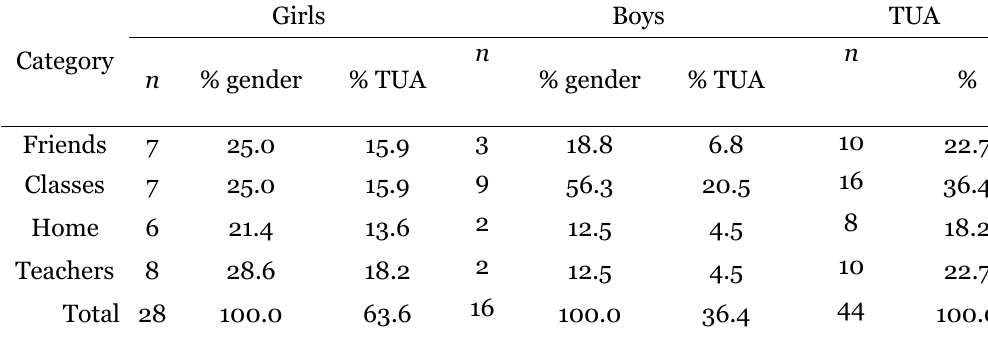
Distribution of Units of Analysis by Category and Among Girls and Boys Girls Category